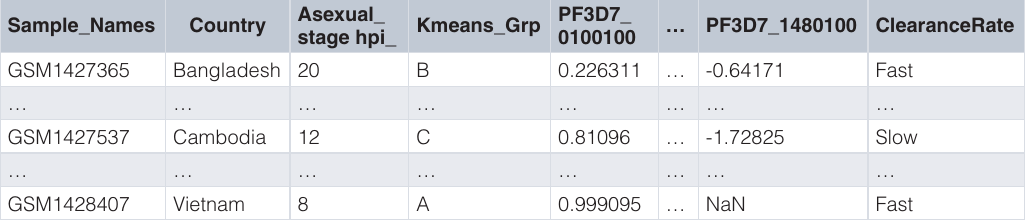
Table 7. Format of the clearance rate model training